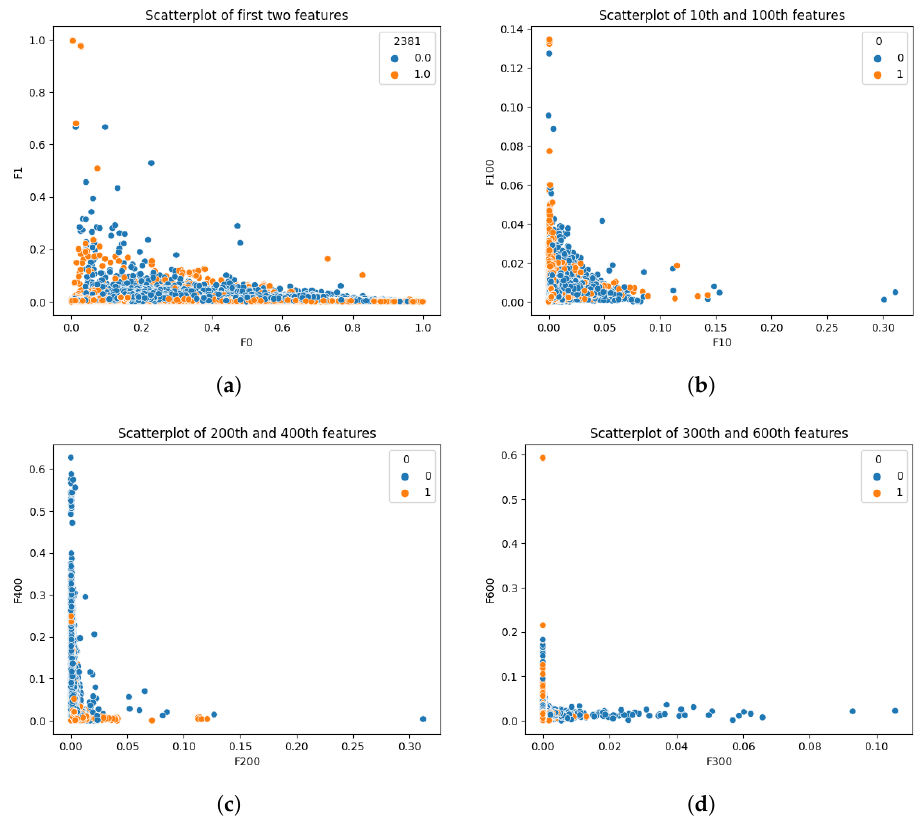
Figure 4. Scatter plot of some random features. ( a ) Scatterplot of first two features; ( b ) Scatterplot of 10th and 100th features; ( c ) Scatterplot of 200th and 400th features; ( d ) Scatterplot of 300th and 600th